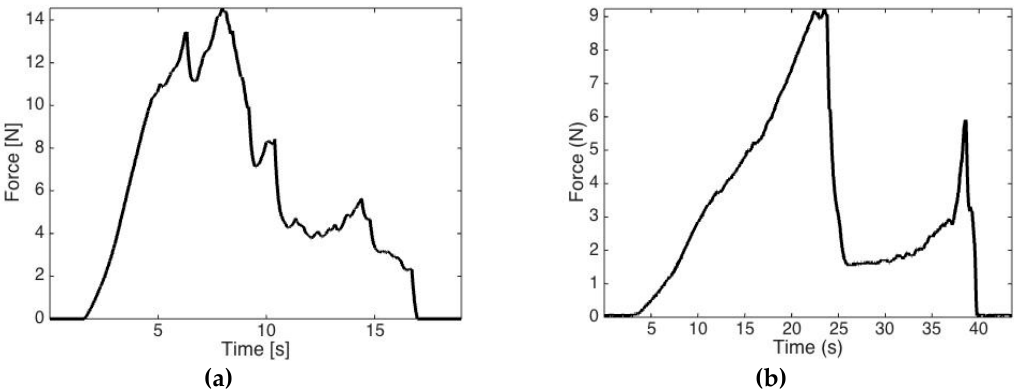
force profile (chicken femur). Figure 8. ( a ) Example of a soft tissue force measurement (bovine liver). ( b ) Example of the bone drilling